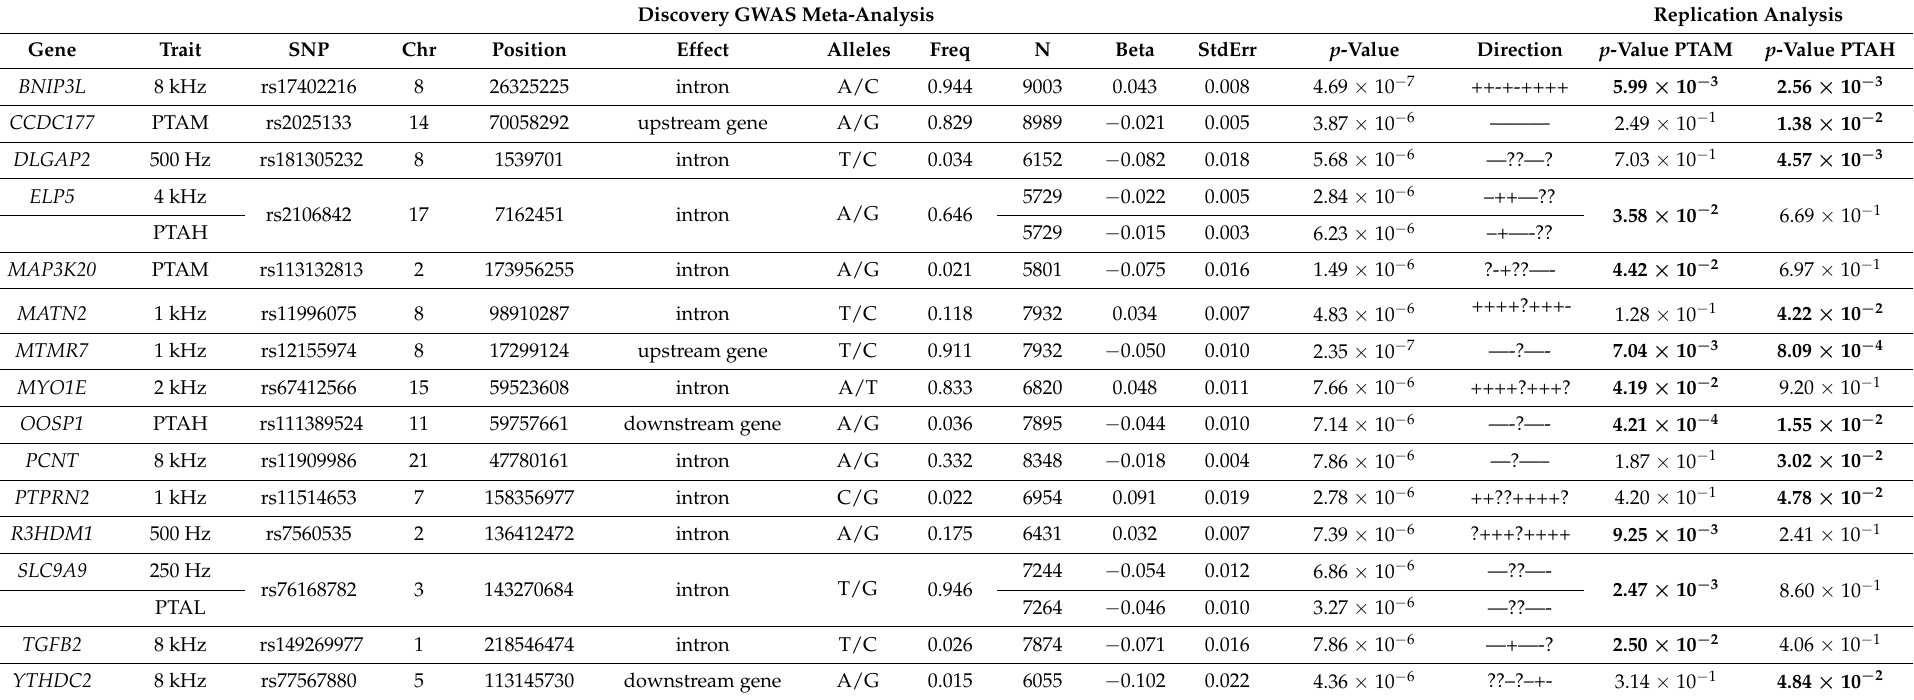
Table 1. The table shows the 15 genes identified by discovery and replication analysis. Columns 2–13 are referred to the discovery GWAS meta-analysis performed with METAL, while the last two are referred to the replication step obtained by gene-based analysis using MAGMA. The columns are Gene: candidate gene; Trait: phenotype in which the gene was identified; SNP: most significant SNP; Chr: chromosome; Position: position of the variant (build hg19); Effect: variant function as obtained using VEP; Alleles: effect allele and other alleles in GWAS meta-analysis; Freq: frequency of the effect allele; N: total analyzed sample size for the variant in the given meta-analysis; Beta effect from GWAS meta-analysis; StdErr: standard error of the beta; p -value: p -value from GWAS meta-analysis; Direction: string summarizing the effect directions (positive or negative) in the involved cohorts, presented in this order: FVG, VBI, CAR, SR, AWP, RS1, RS2, RS3, FHS. A question mark denotes that the variant was not available for the specific cohort; p -value PTAM and p -value PTAH: p -value obtained in the replication step for the gene indicated in the first column in PTAM (Pure Tone Average of thresholds at Medium frequencies) and PTAH (Pure Tone Average of thresholds at High frequencies) phenotypes, respectively. The last two columns indicate in bold the significant (<0.05) p